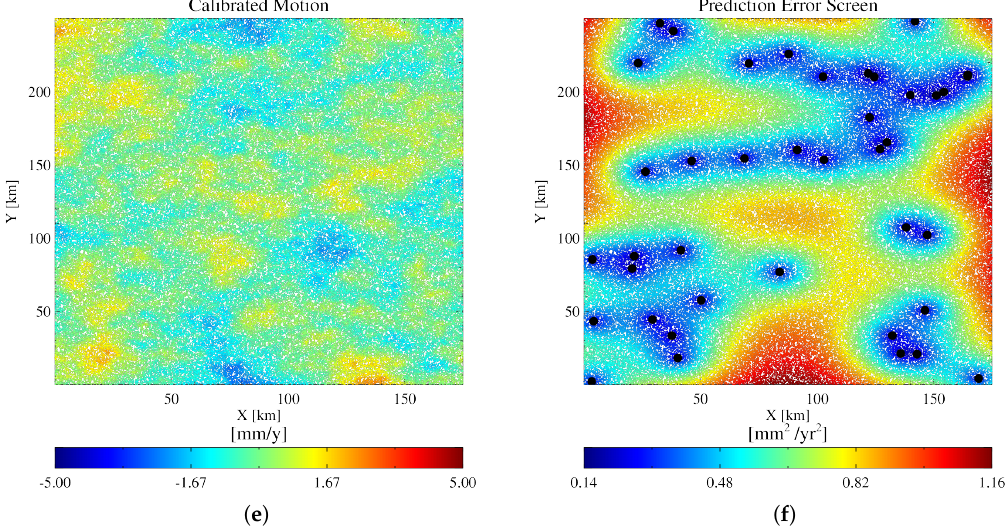
Figure 3. The Figure shows an example of the framework used for the simulations. The simulated motion is 0 over the entire scene. In ( a ), the simulated spatially correlated noise is depicted. In ( b ), the dense Synthetic Aperture Radar Interferometry (InSAR) measurements and the coarse Global Navigation Satellite System (GNSS; large dots, atmosphere-free) are depicted. In ( c ), the measured offsets InSAR/GNSS ( ∆ 0 ) are depicted. In ( d ), the estimated error screen to be removed from ( b ) is depicted. In ( e ), the final results obtained by calibrating ( b ) with ( d ) are depicted. In ( f ), the estimated error for the merged product is depicted.